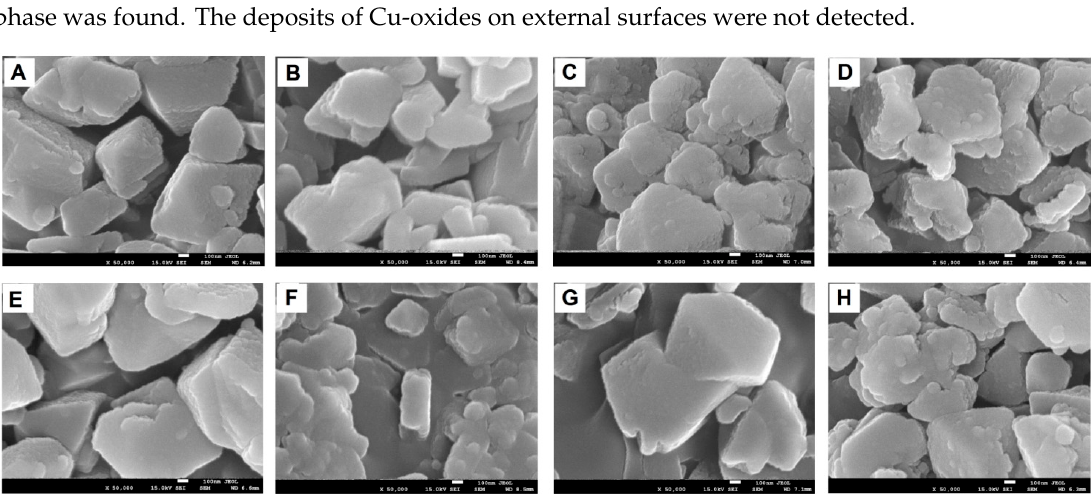
Figure 1. SEM images of the studied samples (50000 × ): ( A ) HFAU, ( B ) Cu(1)HFAU31, ( C ) Cu(2)HFAU, ( D ) Cu(5)HFAU, ( E ) NaFAU, ( F ) Cu(1)NaFAU, ( G ) Cu(2)NaFAU, and ( H ) Cu(5)NaFAU.